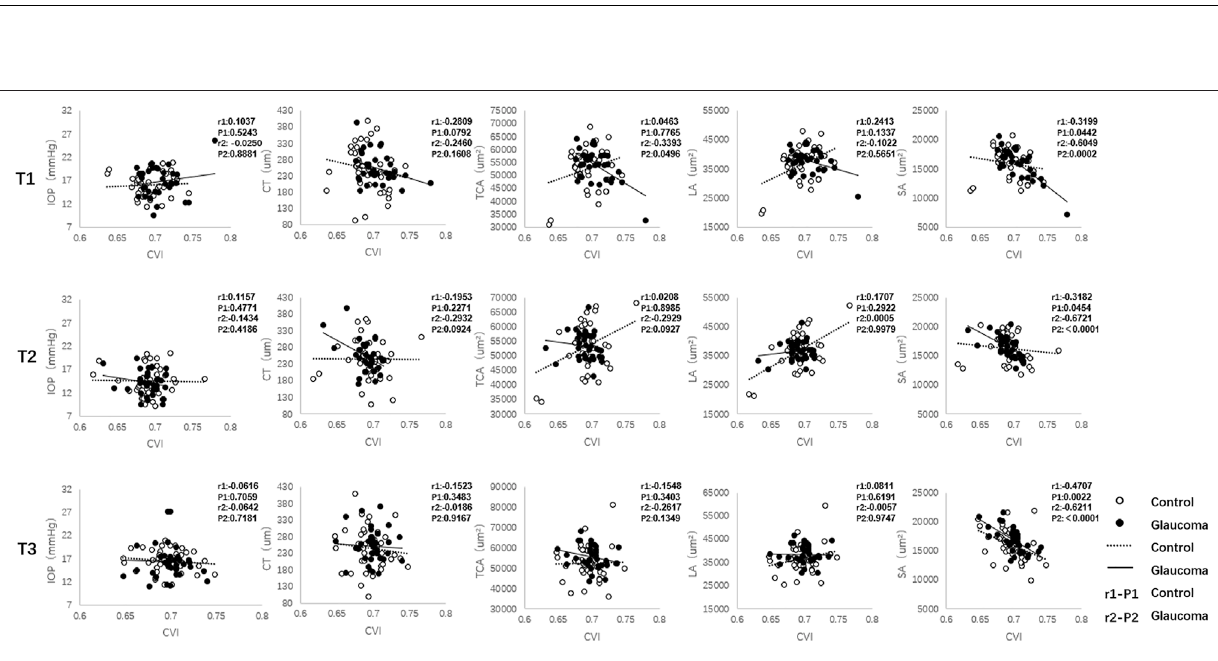
Frontiers in Physiology |